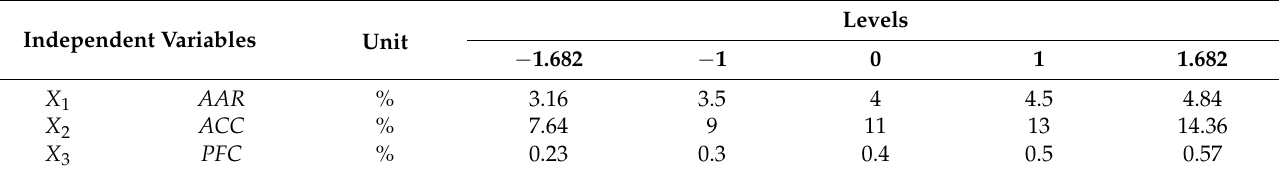
Table 6. Experimental independent variables and levels of